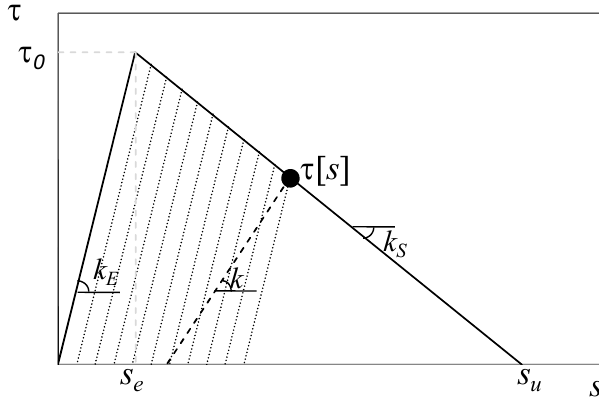
Figure 3. Bond-slip relationship and fracture work: linear softening